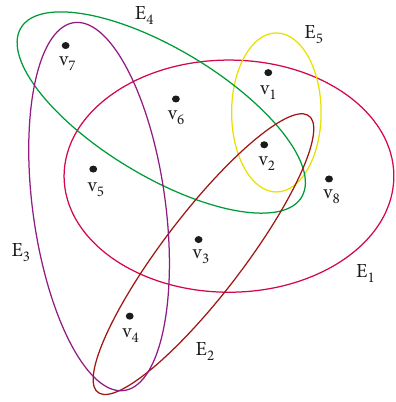
Figure 12: Application of double dominating in IFGH.